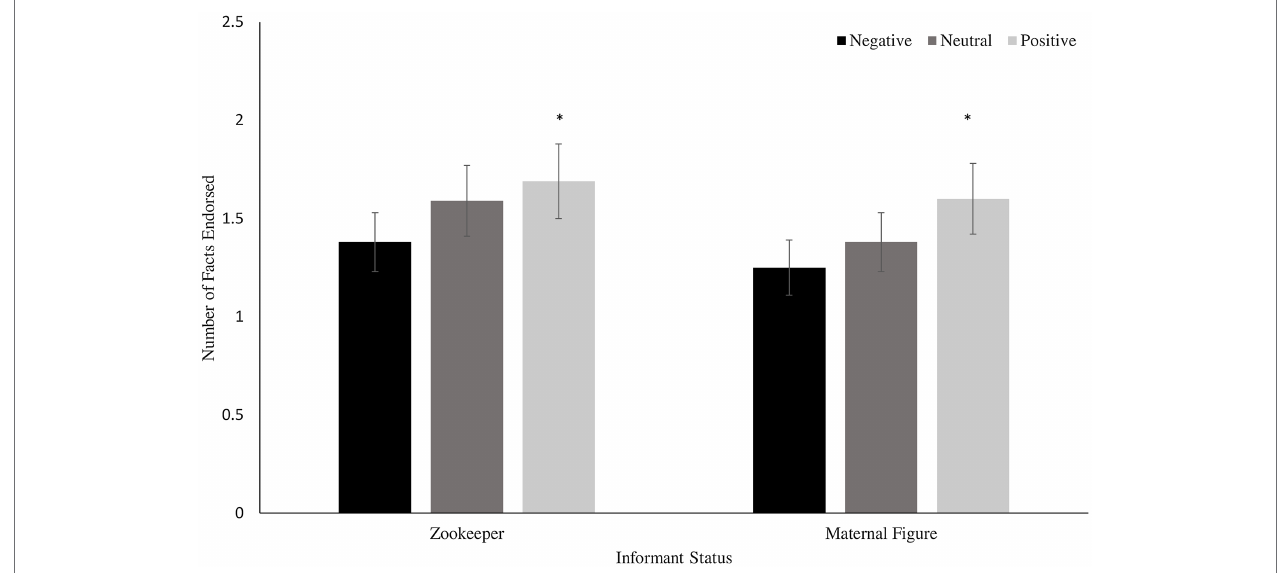
FIGURE 2 | Mean number of facts endorsed as correct by informant status and fact valence. * indicates significantly different from both negative and neutral facts, p < 0.05. Error bars reflect standard